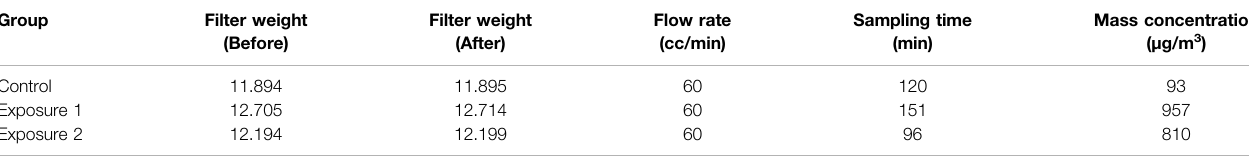
TABLE 5 | Mass concentration of 3-D printer emission sampled during 2-h exposure. Group Filter weight (Before)